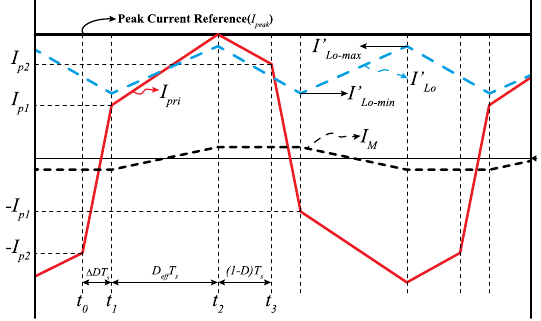
Figure 14. Steady-state current waveforms of the PSFB